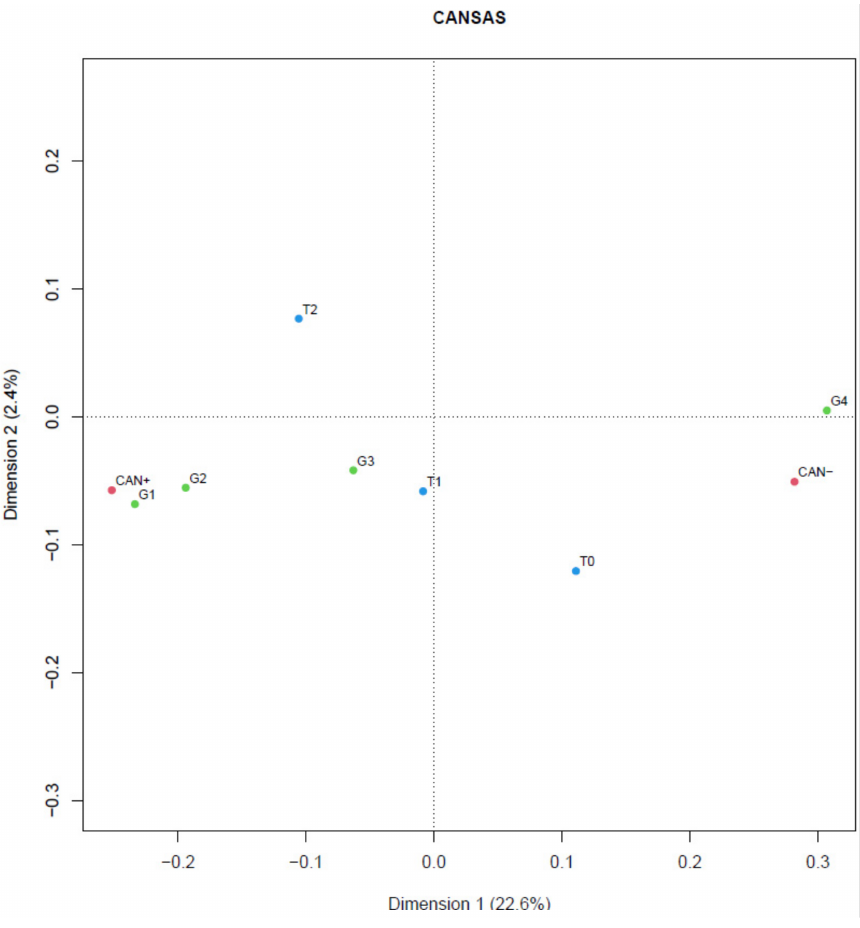
Figure 1. Level of satisfaction of needs in therapeutic-time subgroups-correspondence